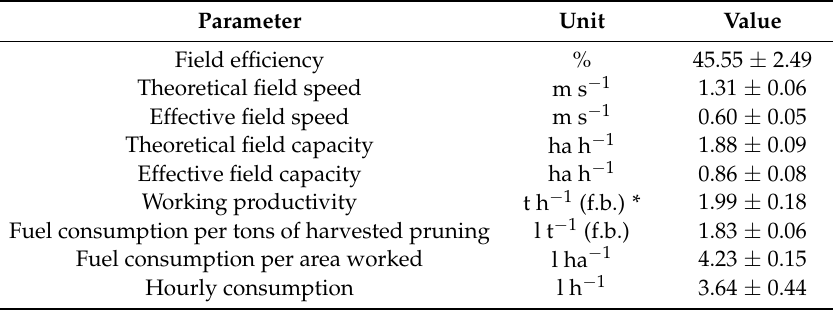
Table 7. Performance and fuel consumption of the